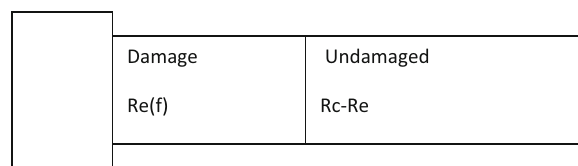
Fig. 3 Diagram for damage and undamage section